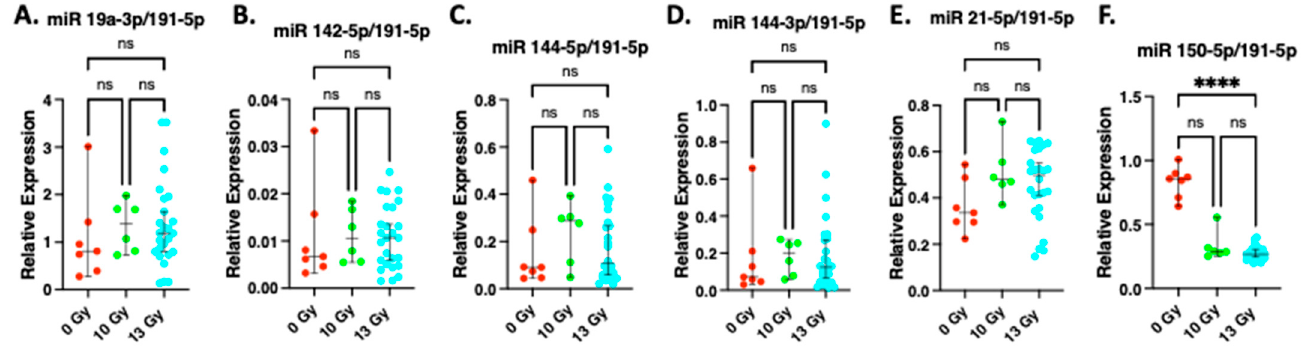
Figure 4. miRNA expression relative to miRNA 191-5p: Graphical representation of circulating miRNA from total blood after whole thorax lung irradiation (WTLI). Blood was harvested from female nonirradiated (0 Gy) and age-matched rats given 10- and 13-Gy WTLI and miRNA isolated and quantitated by qRT-PCR as described (see Materials and Methods). Normalized expression of miRNA as compared to miR 191-5p: ( A ) miR 19a-3p, ( B ) miR 142-5p, ( C ) miR 144-5p, ( D ) miR 144-3p, ( E ) miR 21-5p, ( F ) miR 150-5p. The data are presented as medians and 95% confidence intervals: **** = p < 0.0001, ns = no statistical difference.